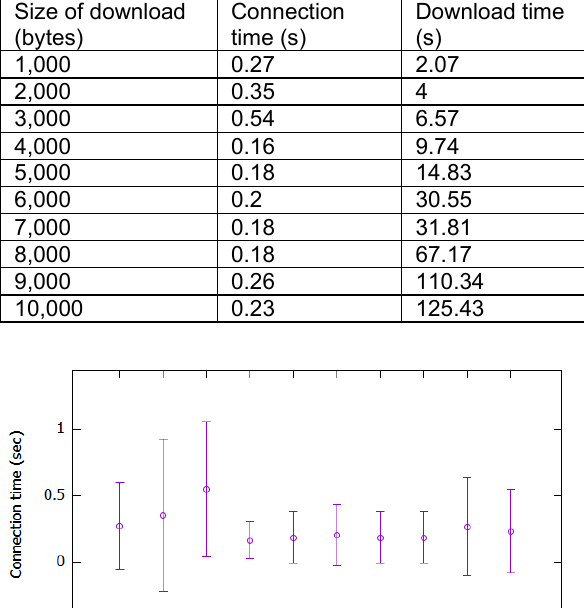
Table 2. Comparison of packet loss rate according to